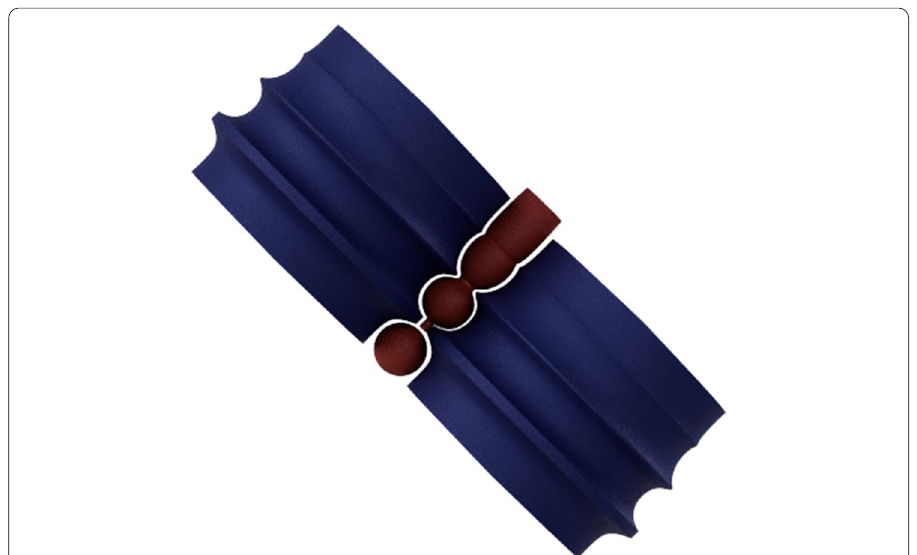
Theoretical simulation